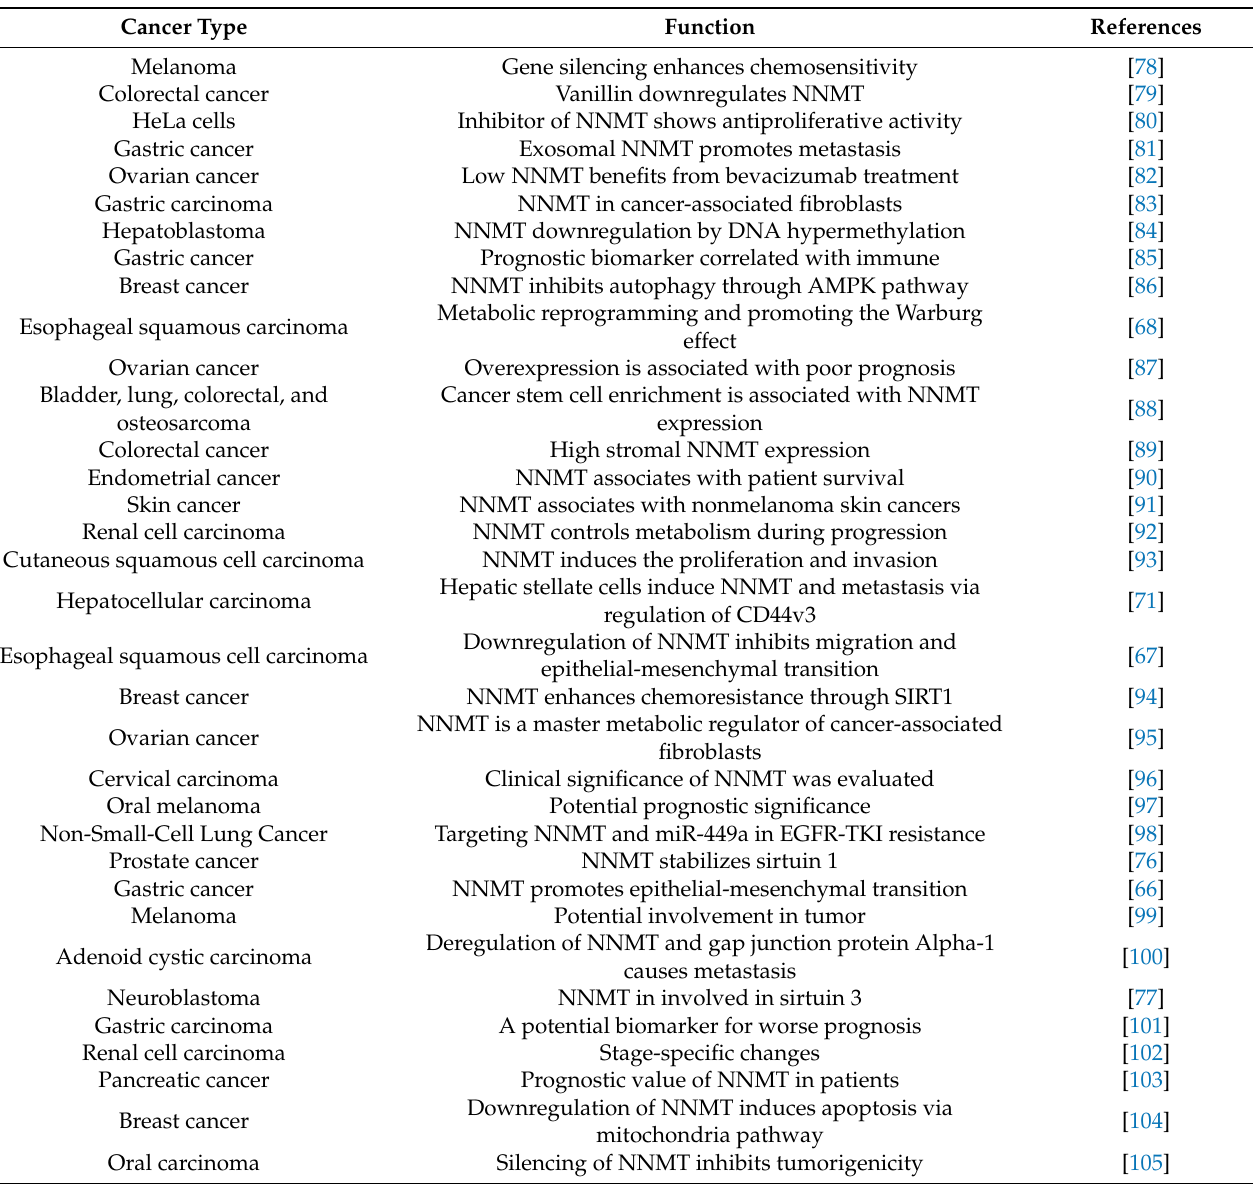
Table 1. NNMT and